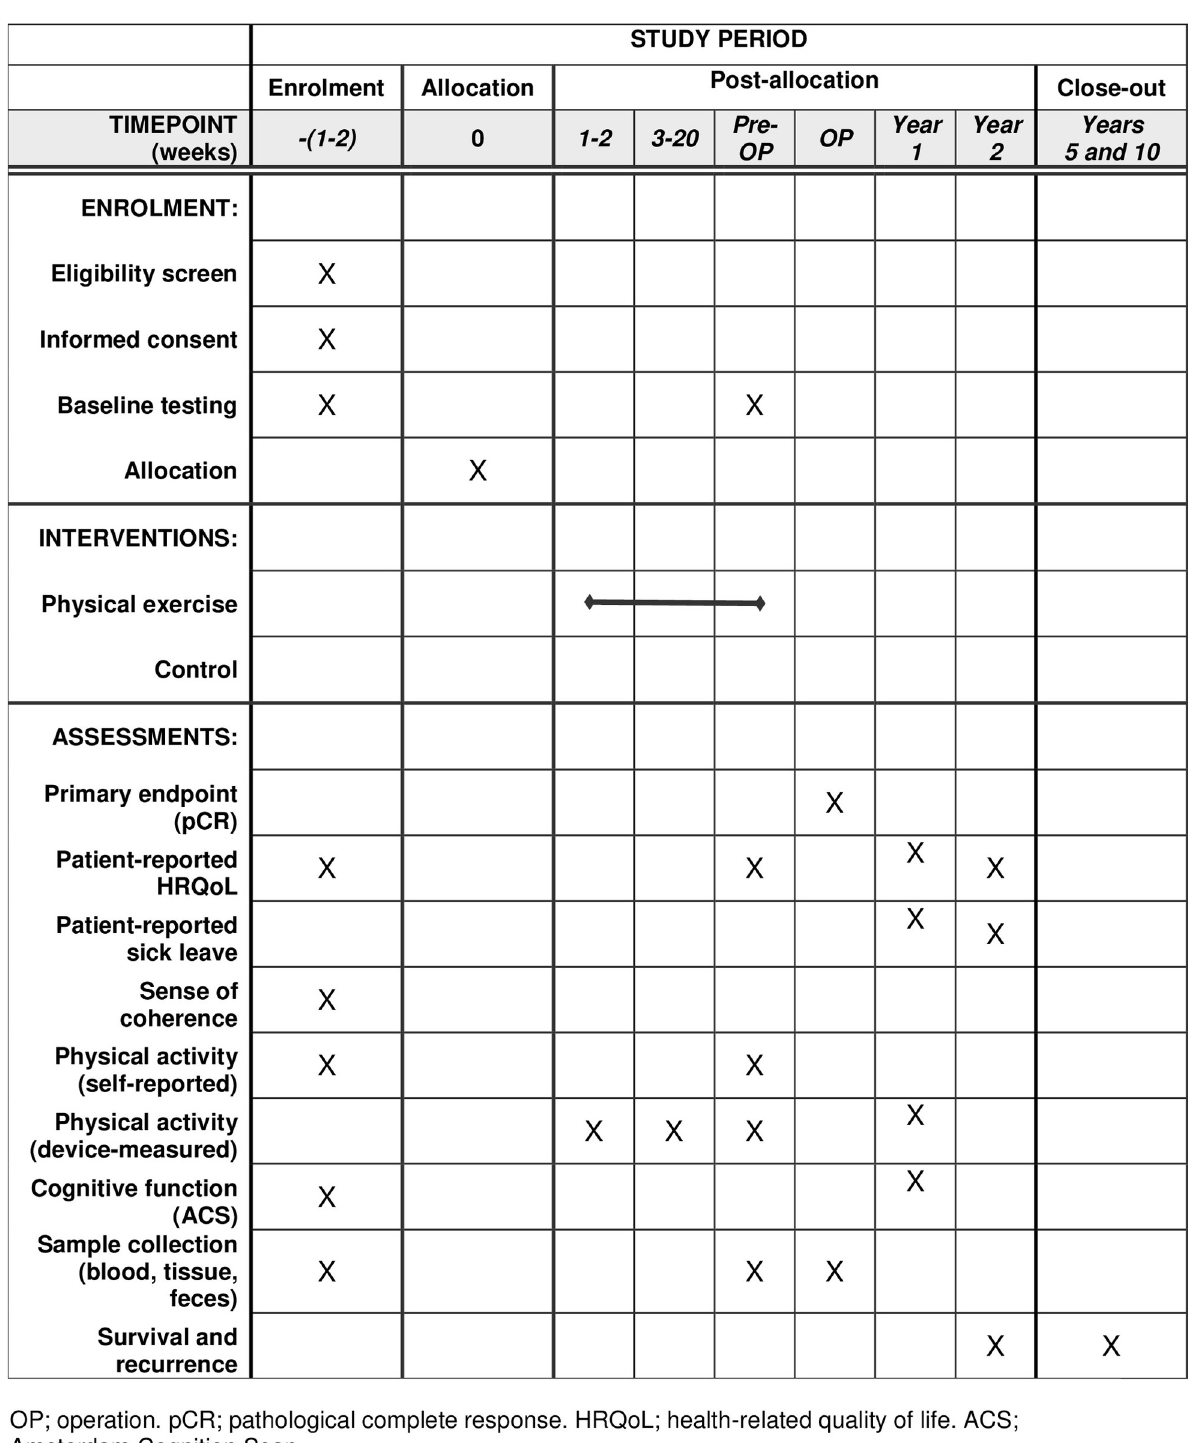
PLOS ONE | https://doi.org/10.1371/journal.pone.0274804 October 13,